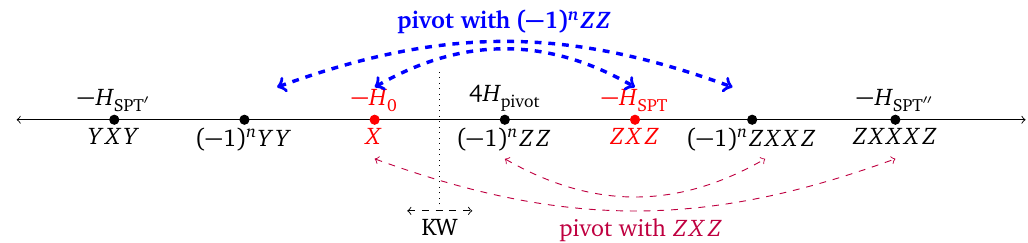
Figure 4: Using the SPT Hamiltonian as a pivot gives rise to a different SPT = − (cid:80) Z X Z phase. Indeed, the cluster chain H and the longer-range n − 1 n n + 1 SPT n = − (cid:80) H Z X X X Z are known to be in distinct phases protected by n − 2 n − 1 n n + 1 n + 2 SPT ′′ n (cid:90) × (cid:90) T symmetry [ 27 ] . Continuing this process generates a whole one-dimensional 2 2 array of models which can be rotated into one another. In particular, pivoting around a given Hamiltonian corresponds to spatial inversion in this abstract ‘model space’ (ilustrated by the blue and red dashed lines). non-local Kramers-Wannier duality corresponds to reflecting across an axis which is positioned between